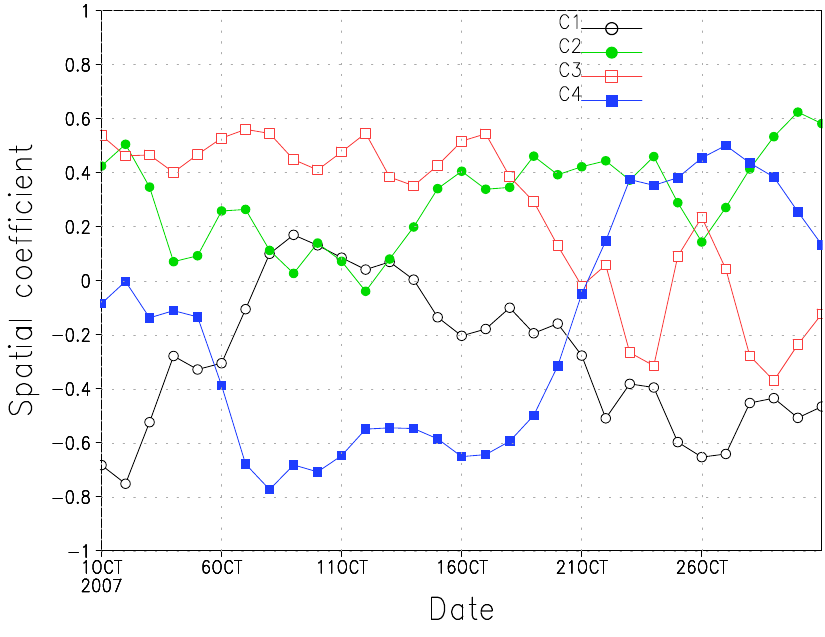
Figure 7. The area-averaged spatial correlation R between 500-mb geopotential heights of daily October 2007 and each cluster. The areal average is taken over the North